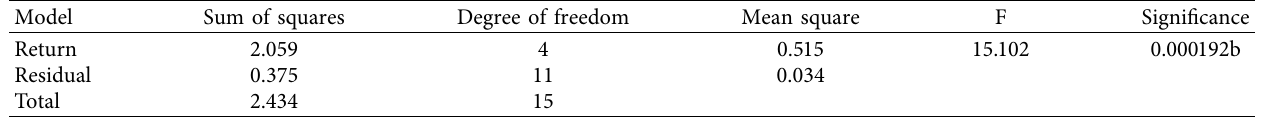
Table 7: Multivariate analysis model significance test table b .